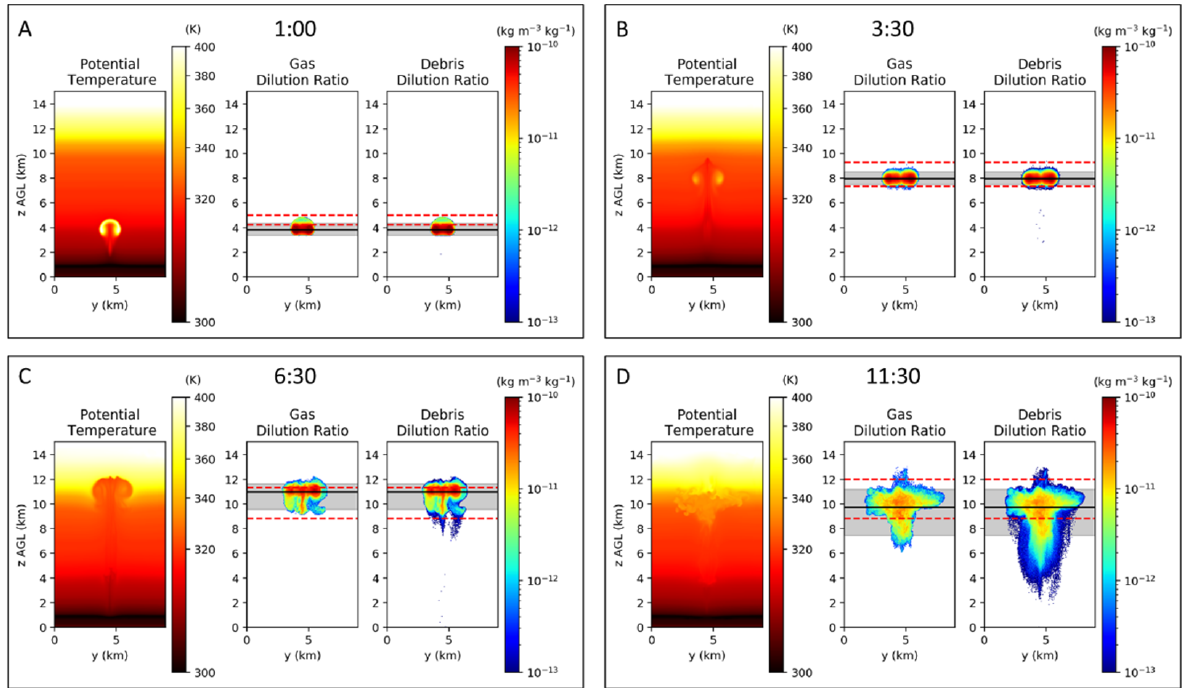
Figure 15. Cloud position and extent at several times using f ent of 0.5. The potential temperature at the cloud center, the average gas dilution ratio, and the average debris dilution ratio are shown at 1.0, 3.5, 6.5, and 11.5 min after detonation in panels ( A – D ), respectively. In the 2D concentration figures, the shaded grey area shows the “cloud vertical extent” described in the text, the black solid line shows the cloud center of mass, and the red dashed lines show the observed cloud top and bottom height.